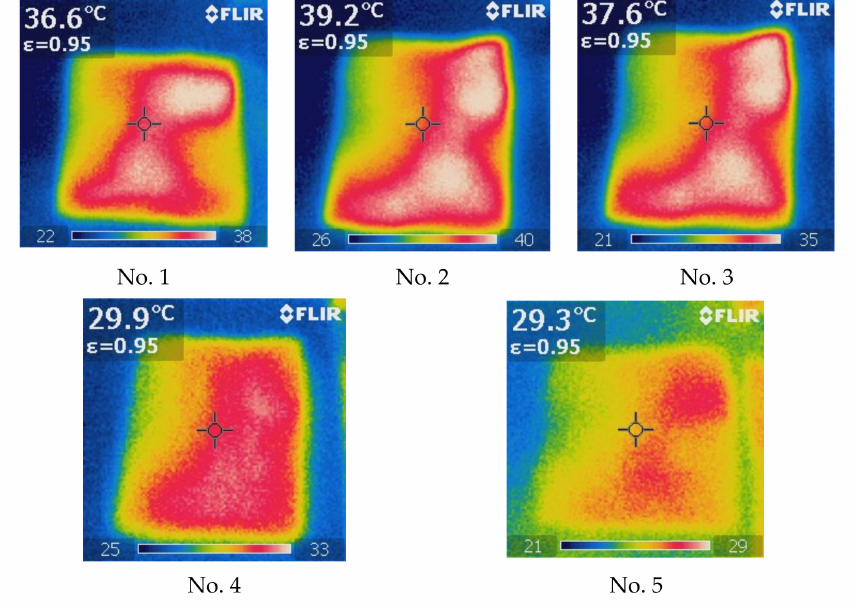
Figure 8. Thermographic images of the measured heating temperatures of the test samples No. 1–No. 5, when the IR exposure time t = 240